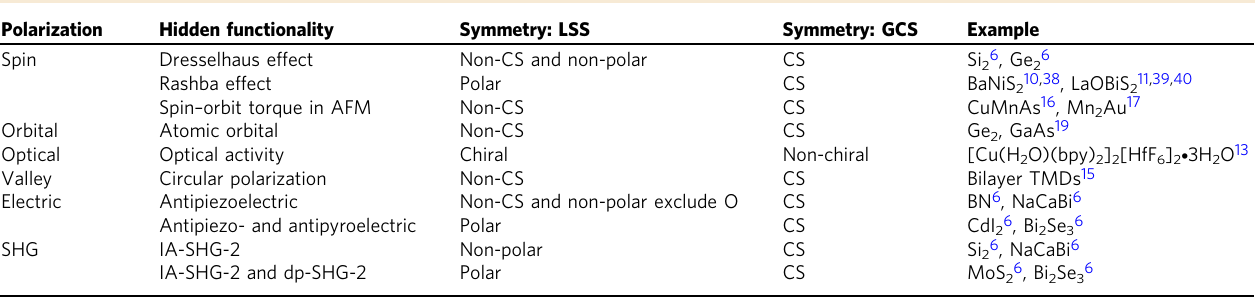
Table 1 Examples of reported hidden effects in centrosymmetric crystals